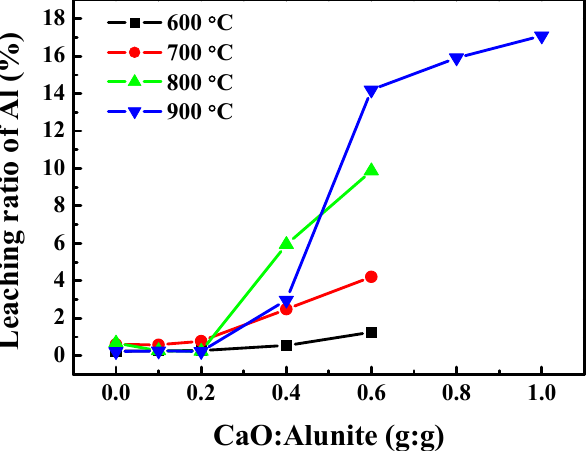
Figure 2. The effect of mass ratio of CaO/alunite on the recovery ratio of aluminum.